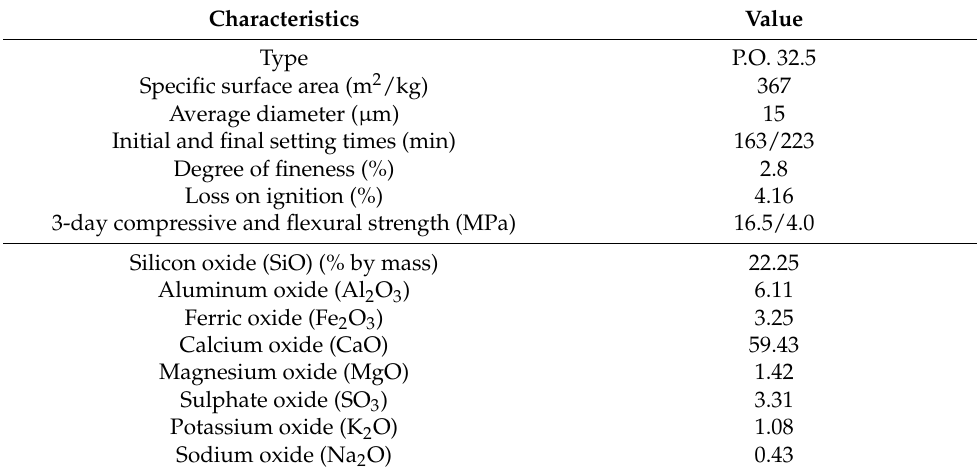
Table 1. Characteristics of the cement.